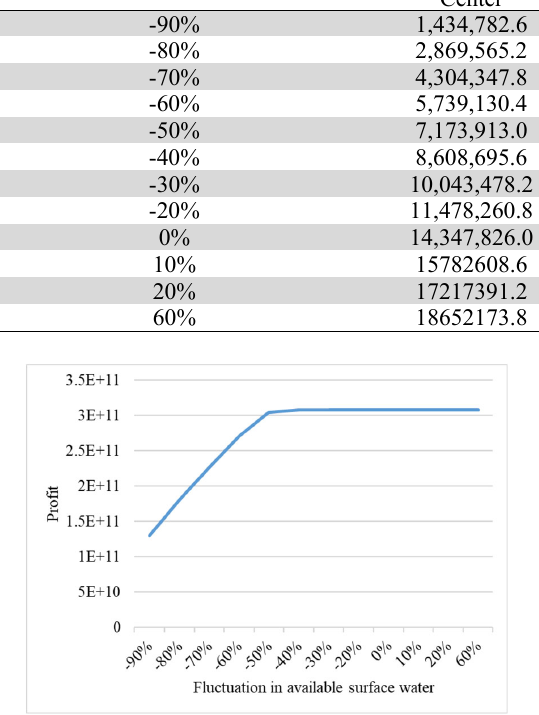
Total profit vs. the available amount of surface water Fluctuation in available surface water